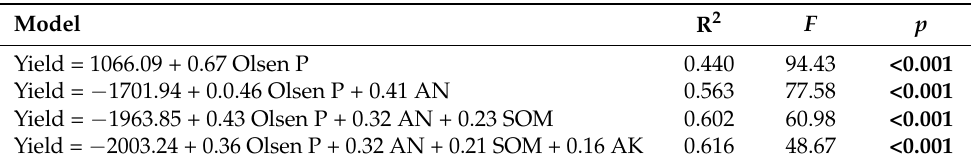
Table 2. The stepwise multiple linear regression analysis of bamboo-shoot yield and soil nutrients’ properties of bamboo forest. Significant effects are given in